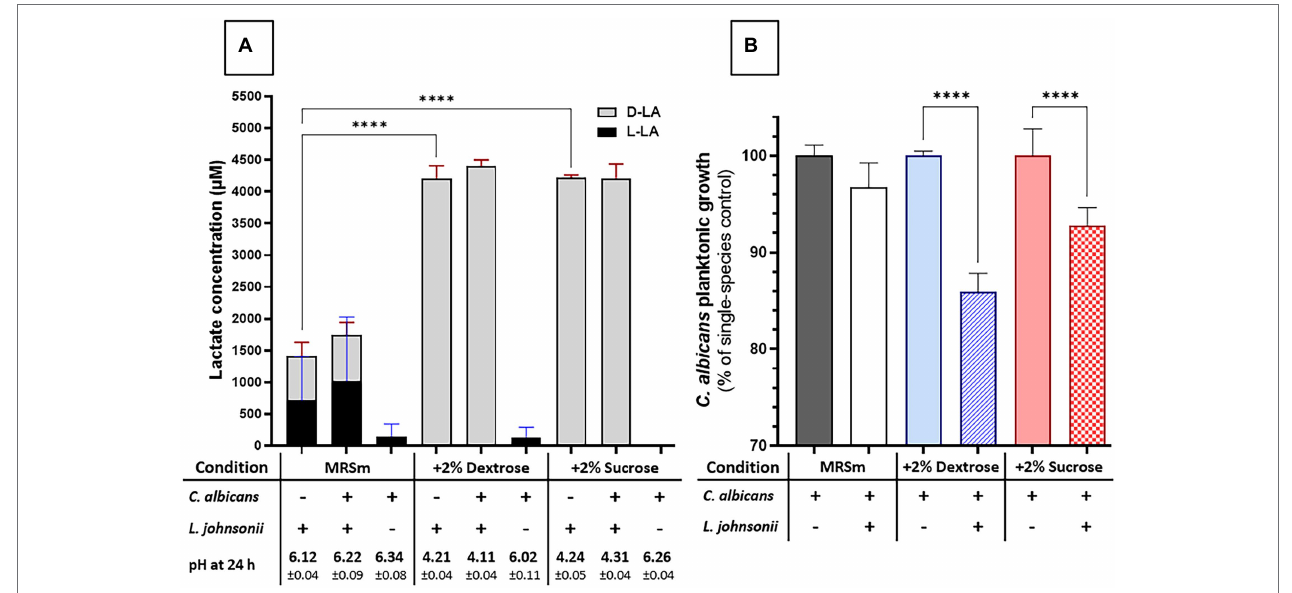
FIGURE 5 | C arbon sources influence L. johnsonii anticandidal activity, lactic acid production, and pH. (A) Lactate production is impacted by availability but not by the type of carbohydrate (i.e., sucrose vs. glucose). The acidification of the culture media correlates to lactate production; (B) The carbohydrate availability and its type influenced the anticandidal activity of L. johnsonii . One-Way ANOVA, Dunnett posttest, **** p ≤ 0.0001. 100% growth corresponds to 6.51 ± 0.06 SD, 7.37 ± 0.02 SD, and 6.71 ± 0.06 SD yeast cells ml − 1 (average, log10 values) in MRSm, MRSm+2% dextrose, and MRSm+2% sucrose, respectively.